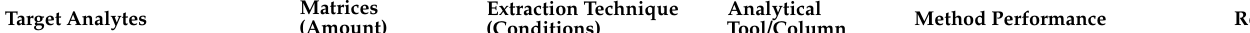
Table 2. Analytical approaches used for determination of phthalates esters (PAEs) in environmental and food samples. Target